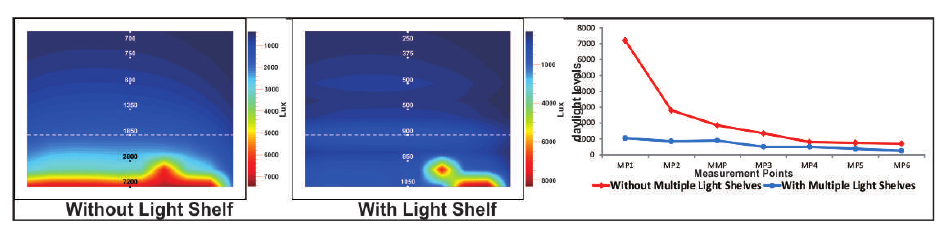
Fig. 11. Comparison of light distribution at 9 a.m.